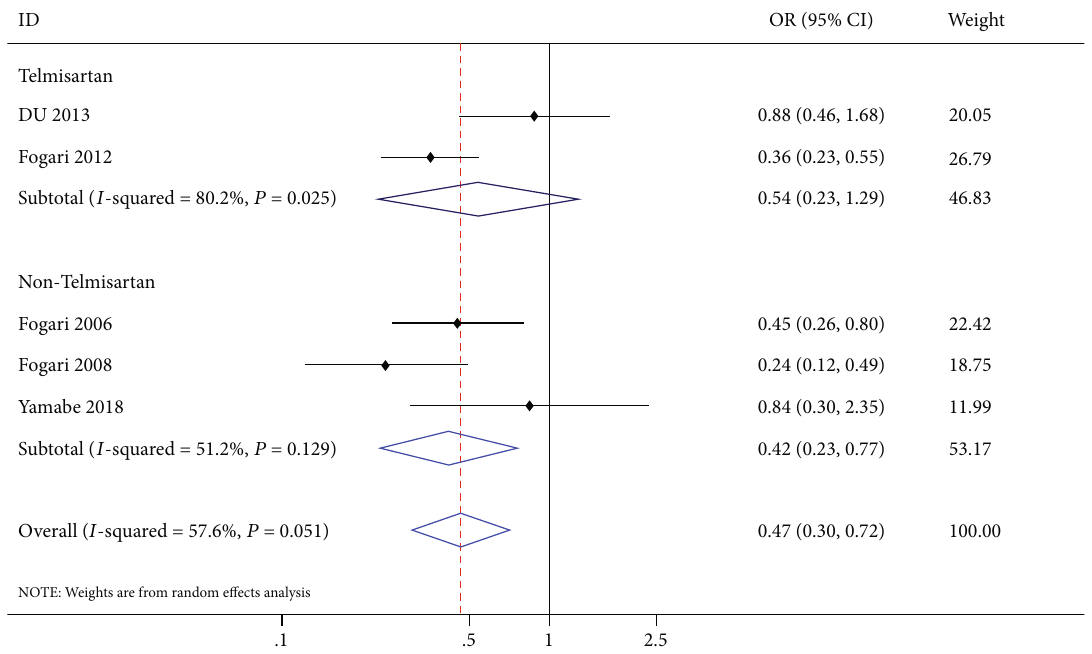
Figure 5: Forrest plot of subgroup analysis with the telmisartan group and nontelmisartan group in AF recurrence among patients with hypertension and AF.